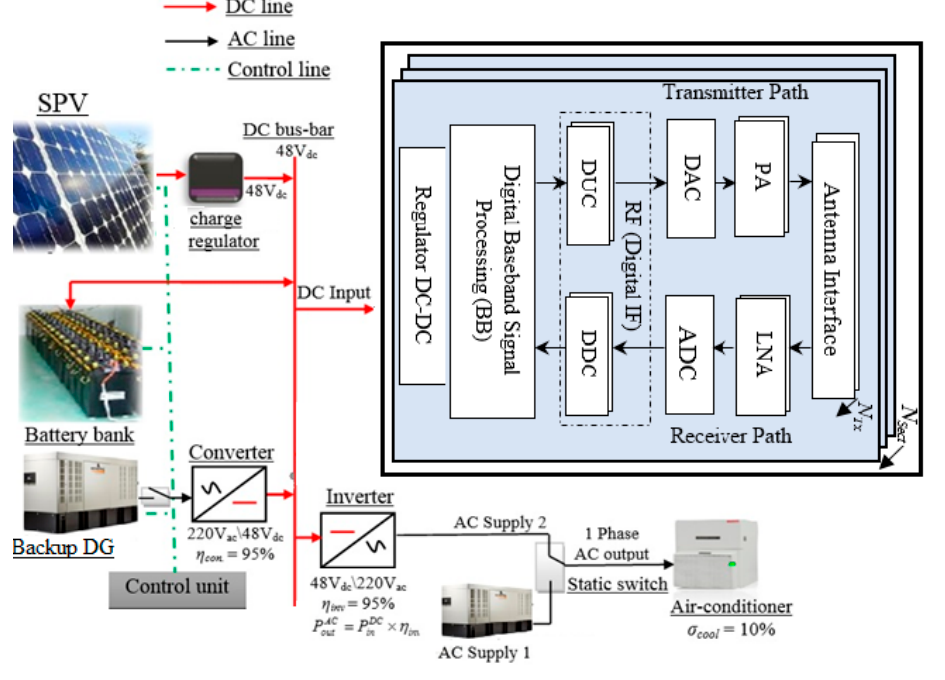
Figure 6. Scheme of the solar-powered BS. Table 3. Key features of the battery models that are used with cellular BSs [91].